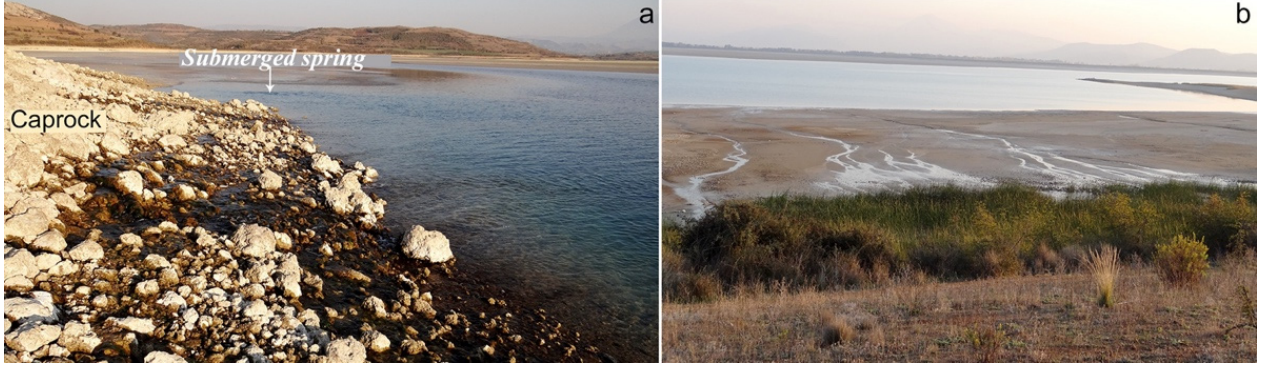
Figure 6. ( a ) Big linear springs issuing from caprock (in the foreground) and a submerged spring just offshore; ( b ) small linear spring in the northern part of Thana Lake.